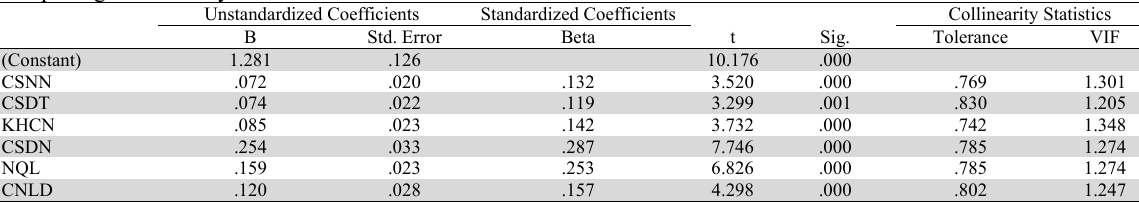
Multiple regression